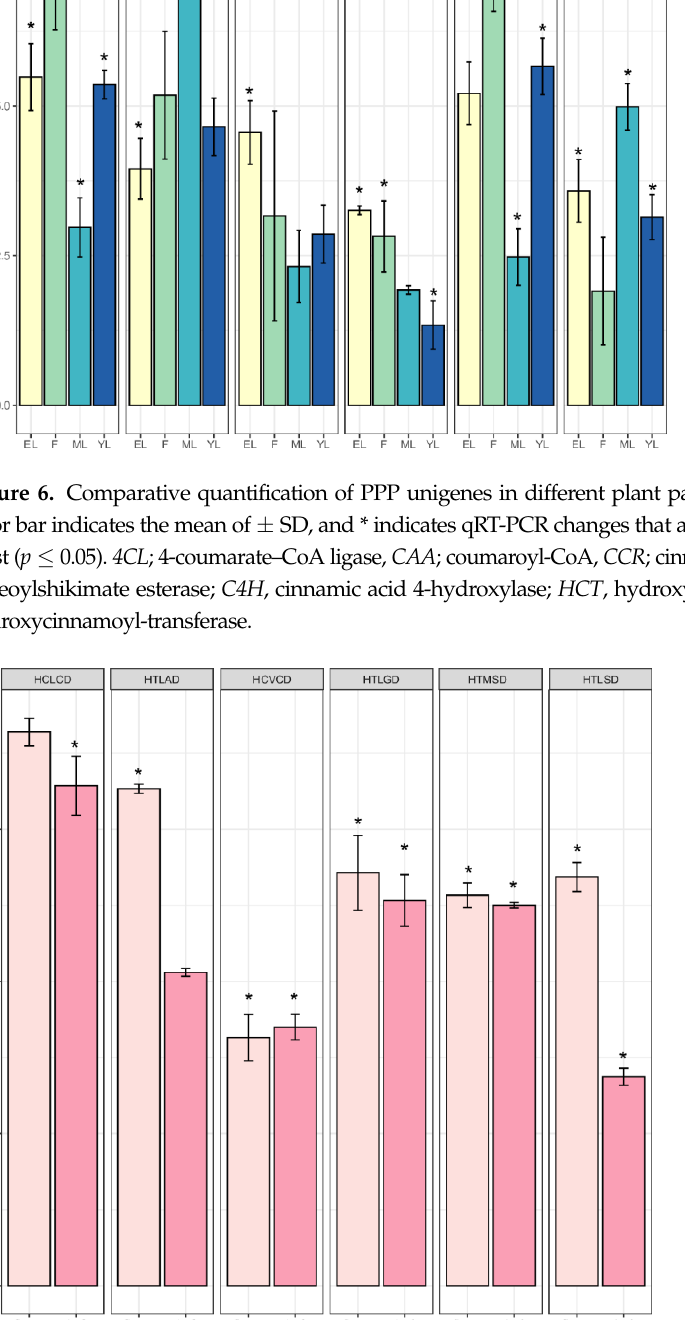
Figure 7. Overlay of quantified expression of HXXXD—hydroxycinnamoyl acyltransferase unigenes in flower and leaf of A . spathulifolius. The error bar indicates the mean ± SD, and * indicates qRT-PCR changes that are statistically significant by t -test ( p ≤ 0.05). Note: HTLAD and HTLSD belong to HQT class domain.